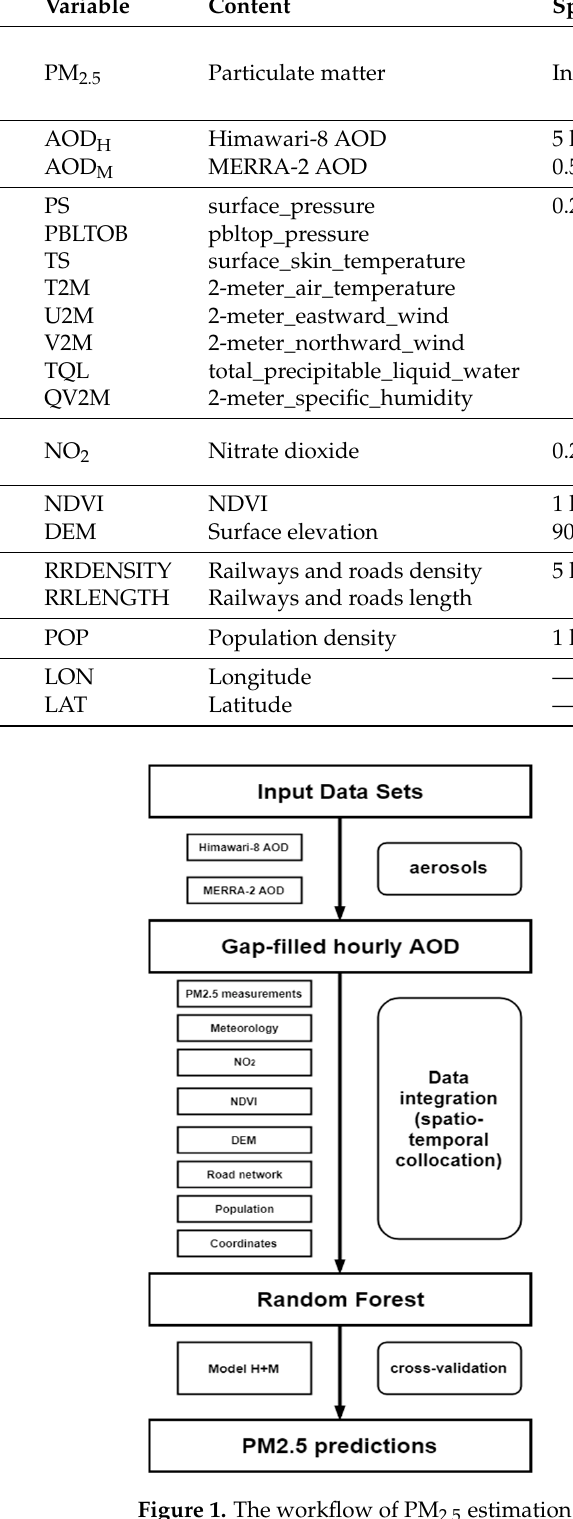
2.5 estimation in this